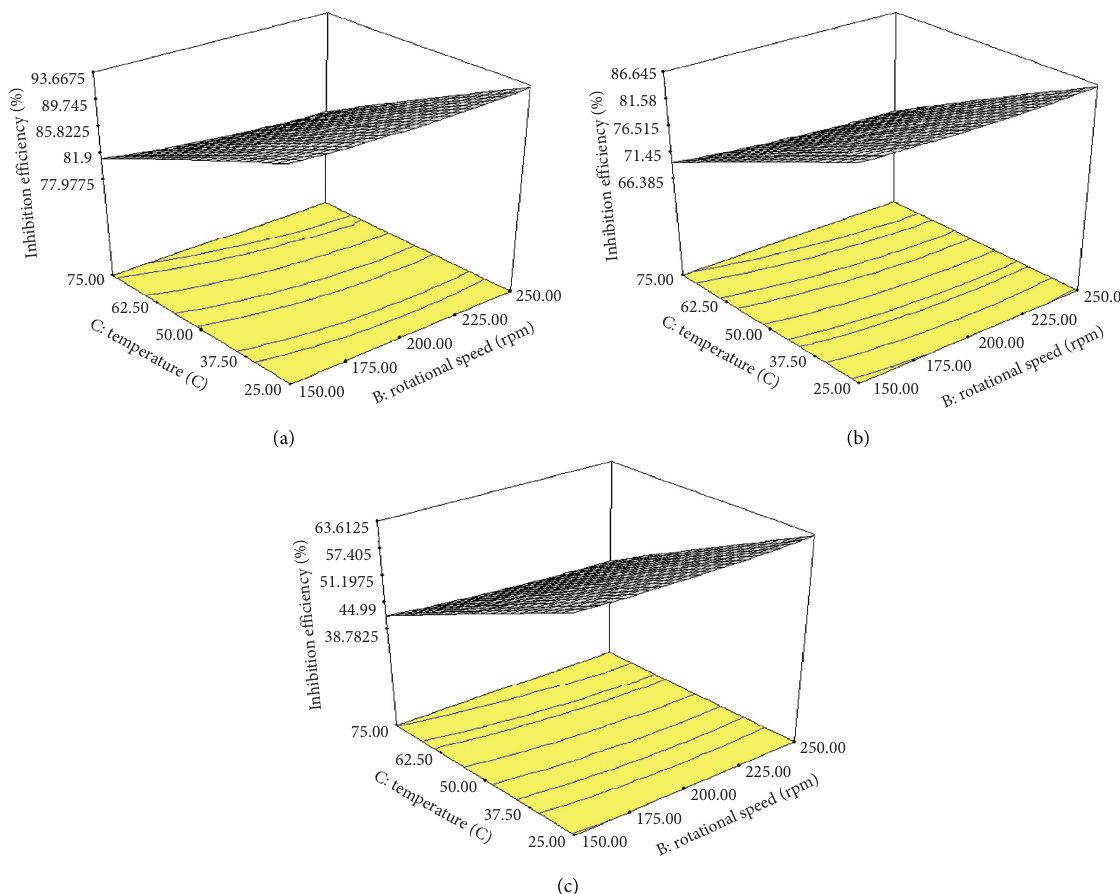
Figure 19: 3D plot of inhibition efficiency as a purpose of rotational speed and temperature at the inhibitor loads (a) 10%, (b) 7.5%, and (c) 5%.